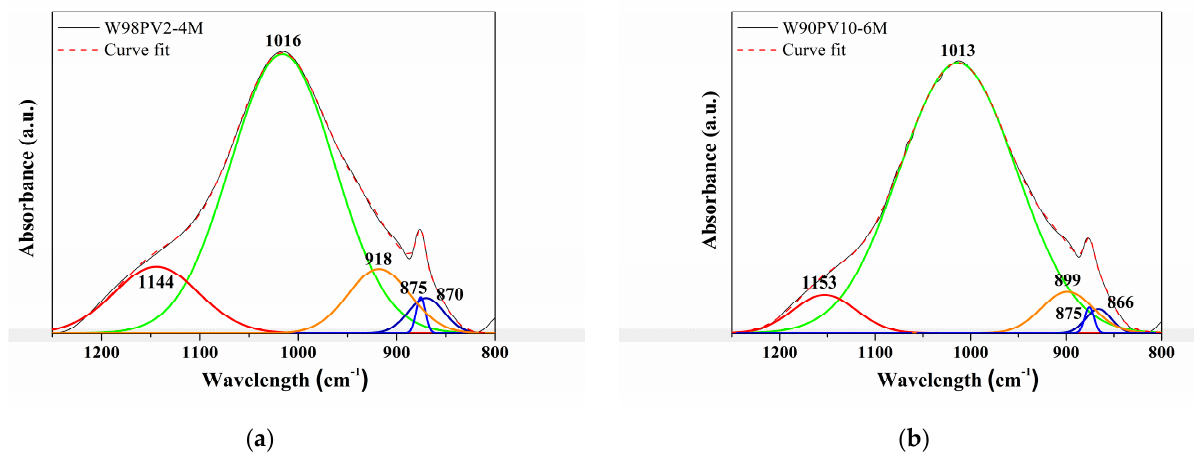
Figure 6. FT-IR deconvoluted spectra of ( a ) the W98PV2-4M sample and ( b ) W90PV10-6M sample. Figure 7 depicts the FT-IR spectra of the W98PV2-4M and W90PV10-6M samples be- fore and after the selective chemical extractions. The shift and displacement of the broad band (1009–1013 cm − 1 ) towards a higher frequency (1064 cm − 1 ) indicates the dissolution of the C-S-H, C-A-S-H, and (C,N)-A-S-H phases. The dissolution of these phases produced three characteristic peaks that indicate the presence of silica gel (790, 945, and 1064 cm − 1 )